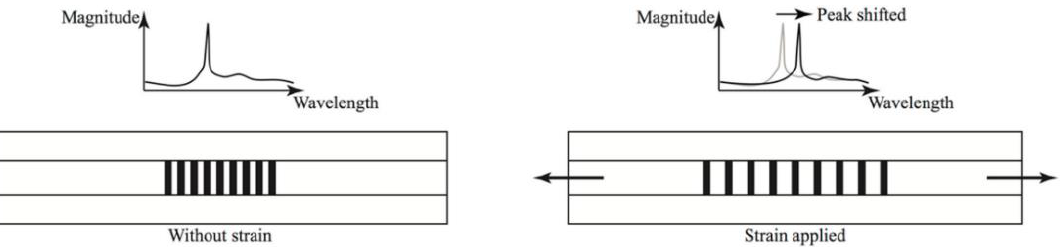
Figure 15. The response of a Bragg grating to an applied strain. (Reprinted from ref. [66]).